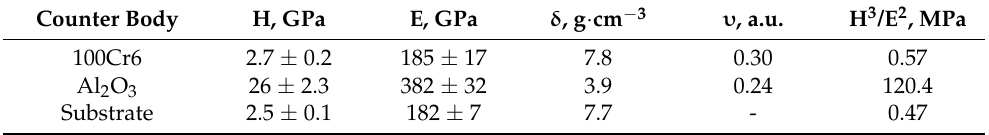
Table 1. Physical and mechanical properties of counter bodies [40] and